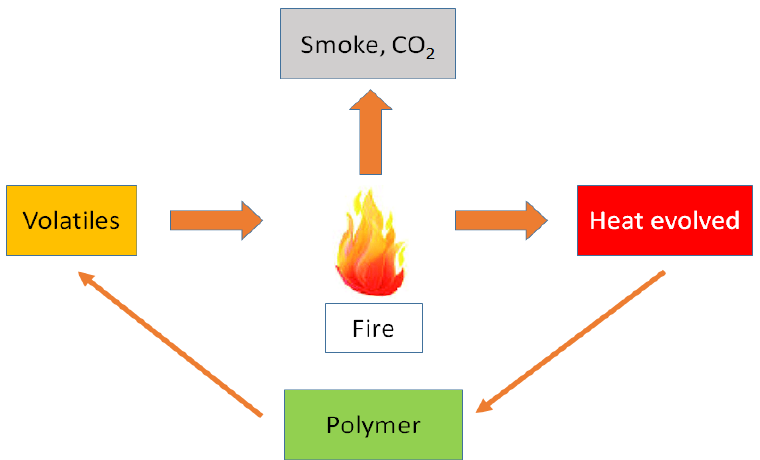
Figure 3. Schematic diagram of a burning cycle.